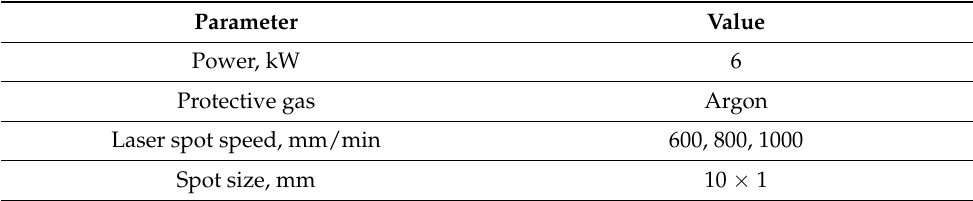
Table 1. Laser remelting